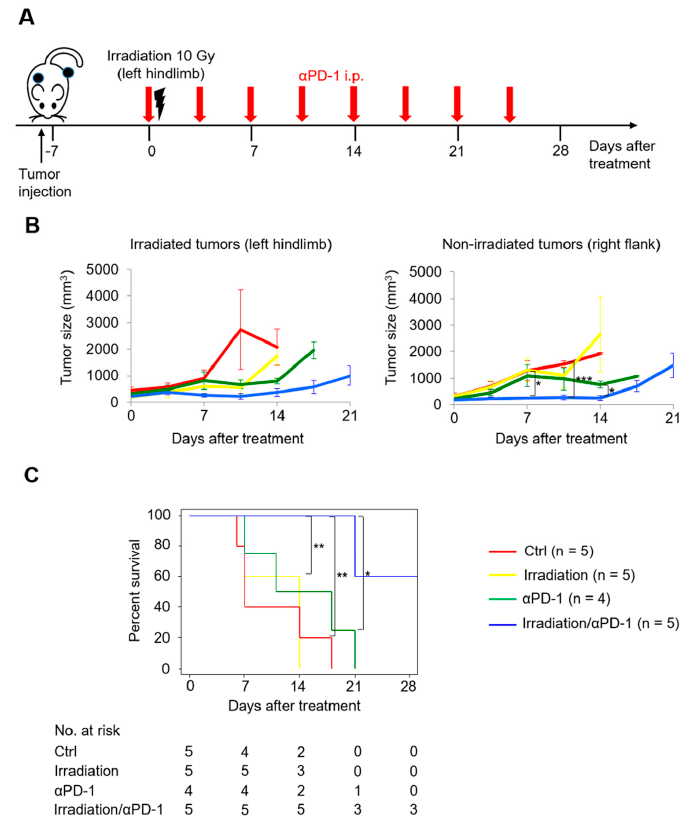
Figure 2. Concurrent anti–PD-1 treatment facilitated abscopal effects induced by a single dose of irradiation in MB49 tumor-bearing mice. ( A ) Scheme for tumor inoculation and treatments. Six- to seven-week-old mice are inoculated subcutaneously with MB49 cells in the left hindlimb and in the right flank, and seven days later, receive irradiation with a single fraction of 10 Gy to the left hindlimb and anti–PD-1 treatment (or its isotype controls). ( B ) MB49 tumor growth curves of irradiated tumors in the left hindlimb (left) and nonirradiated tumors in the right flank (right). ( C ) Survival curves of mice. Log-rank test is used to compare survival curves. All data are shown as the mean ± standard error of the mean (SEM). Asterisks indicate p -values comparing two groups, as indicated in the figure. * p < 0.05; ** p < 0.01; *** p <